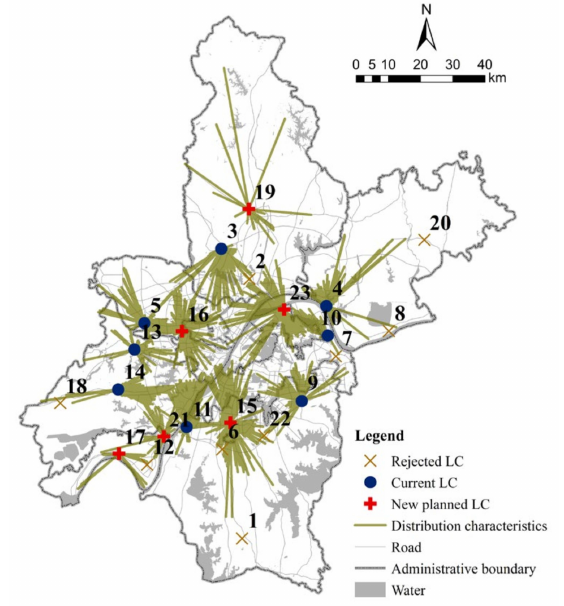
Figure 11. Site location and allocation results by the improved P-median method.